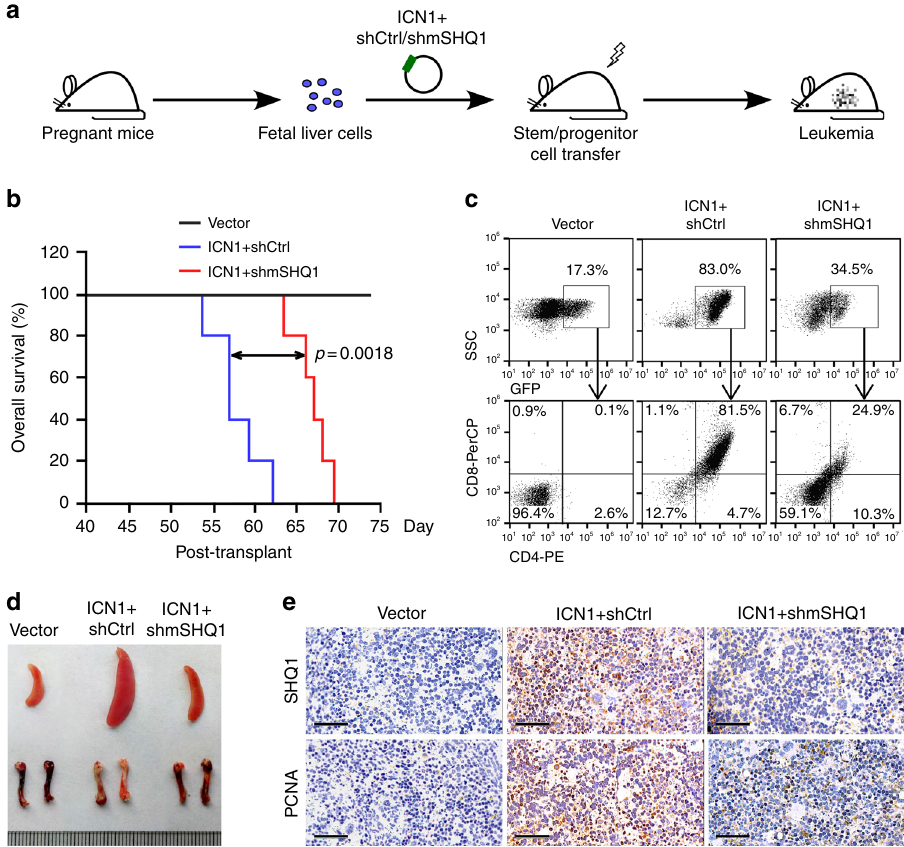
Fig. 5 SHQ1 depletion impedes leukemogenesis in NOTCH1-induced T-ALL model. a Graphical illustration of NOTCH1-induced T-ALL mouse model. Fetal liver cells were infected with MSCV retrovirus, enabling simultaneously expression of ICN1 and shRNA targeting non-speci fi c control (shCtrl) or murine SHQ1 (shmSHQ1). Two million GFP + transduced cells were intravenously injected into each irradiated recipient, followed by assessment of leukemia cell dissemination. b Kaplan – Meier survival curves of fetal liver cell transplants expressing vector (black line, n = 5), ICN1/shCtrl (blue line, n = 5), or ICN1/ shmSHQ1 (red line, n = 5). The p value was determined by log-rank test. Around day 55 post transplantation, ICN1/shCtrl mice became moribund, then three mice in each group were killed for assessment of T-ALL in vivo. c Representative fl ow cytometry analysis of GFP + and CD4 + CD8 + leukemia cell distribution in each group. d Representative spleen and bone images in each transplant. e Representative histological images of murine SHQ1 and PCNA in spleen sections from each group. Scale bar, 50 μ